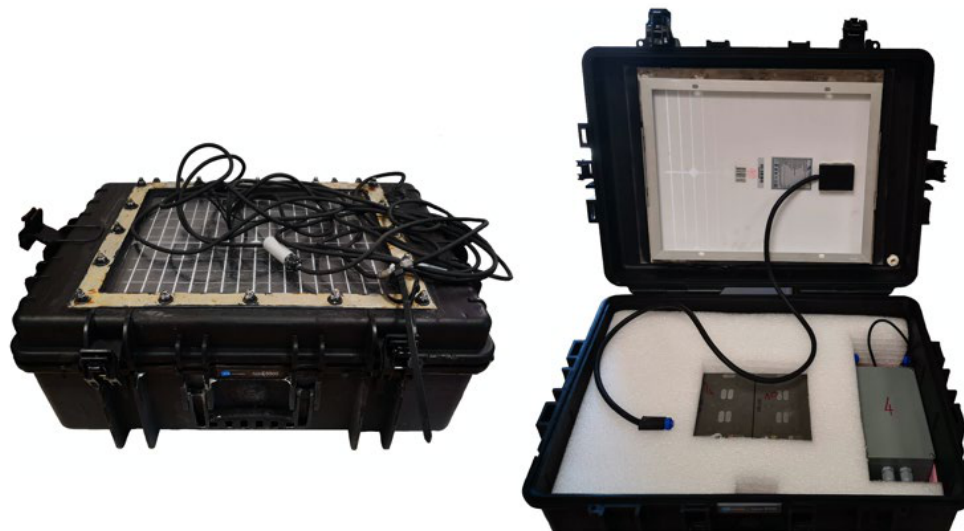
Figure 1. Schematic diagram of the system subdivided in four parts numbered from 1 to 4 describing the transmission of data from acquisition to delivery: (1) in situ recording devices, (2) communication in real time via GSM network, (3) raw data storage and processing server and (4) export and visualization tools.